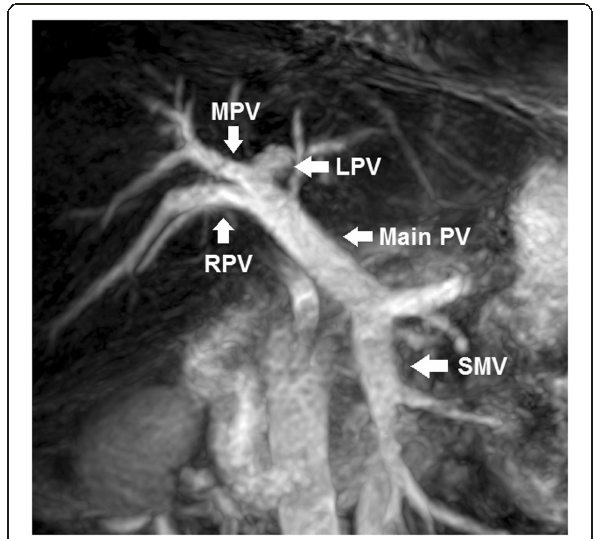
Fig. 6 Portal vein trifurcation. Coronal maximum intensity projection image from a non-contrast MR portography using T-SLIP technique showing anatomical variant where the main portal vein trifurcates into the right portal vein (RPV), middle portal vein (MPV), and left portal vein